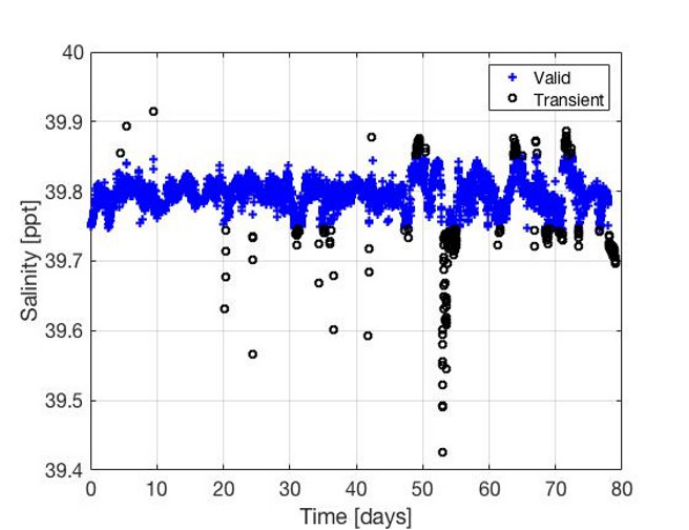
Figure 4. Classification of a THEMO salinity dataset into valid (blue plus marks) and transient (black circles) data using predictions from a water temperature